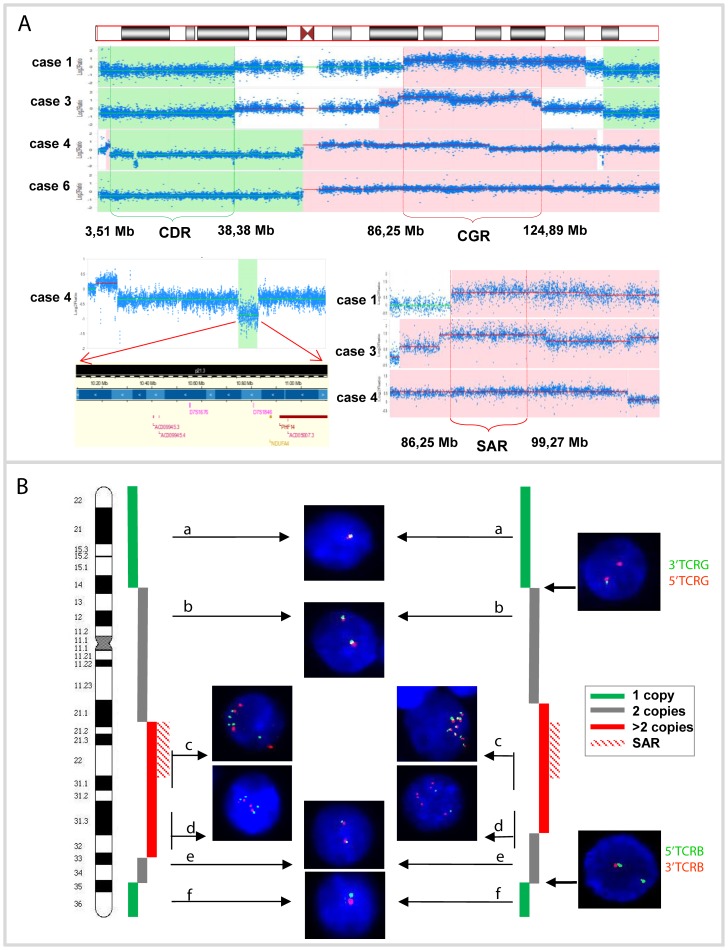
Examples of aCGH and FISH analysis.A) upper panel: genomic profile of chromosome 7 of four index cases with the indicated common deleted region (CDR) on 7p and common gained region (CGR) on 7q; lower left panel: gene content (Hg19) of the biallelically deleted 7p21 interval in case 4; lower right panel: zoomed CDR with the indicated selectively amplified region (SAR). B) Examples of interphase FISH validation of aCGH results performed in cases 1 (left panel) and 2 (right panel) with r(7). Applied probes: (a) RP11-99J06-SG/RP11-735O20-SO, (b) RP13-11C11-SG/RP11-807G04-SO, (c) RP11-513N08-SG/RP11-514N09-SO, (d) RP11-379L24-SO/RP11-16K22-SG,(e) RP11-269N18-SG/RP5-894A10-SO, (f) RP4-548K24-SG/RP11-135F23-SO.